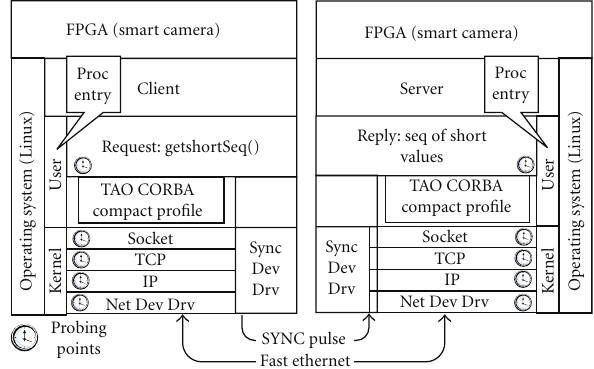
Figure 9: Software ORB experiment